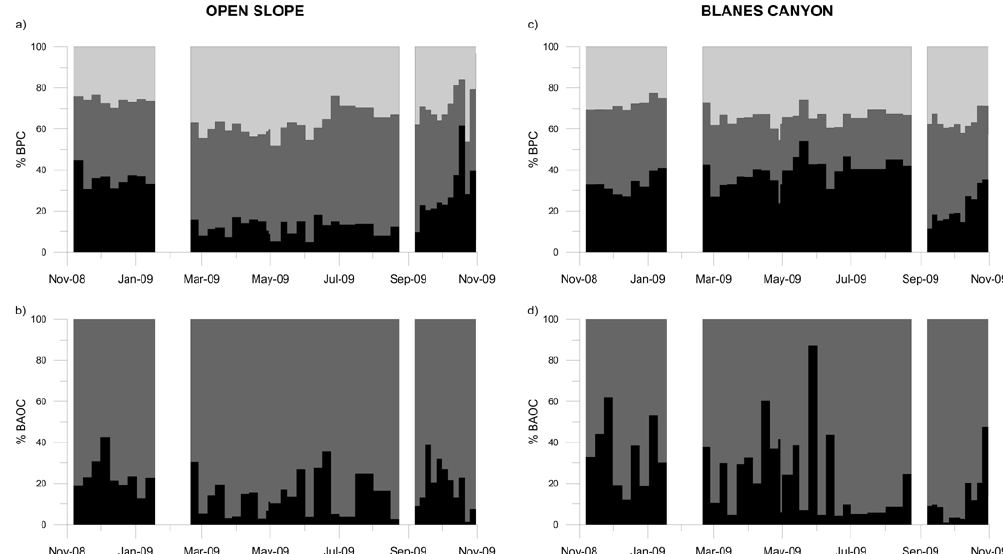
Fig. 5. Temporal changes in the biochemical composition of settling particles at 25mab. Data are presented as percentage contributions of proteins, carbohydrates and lipids to biopolymeric C (% BPC) and as percentage contributions of labile proteins and labile carbohydrates to